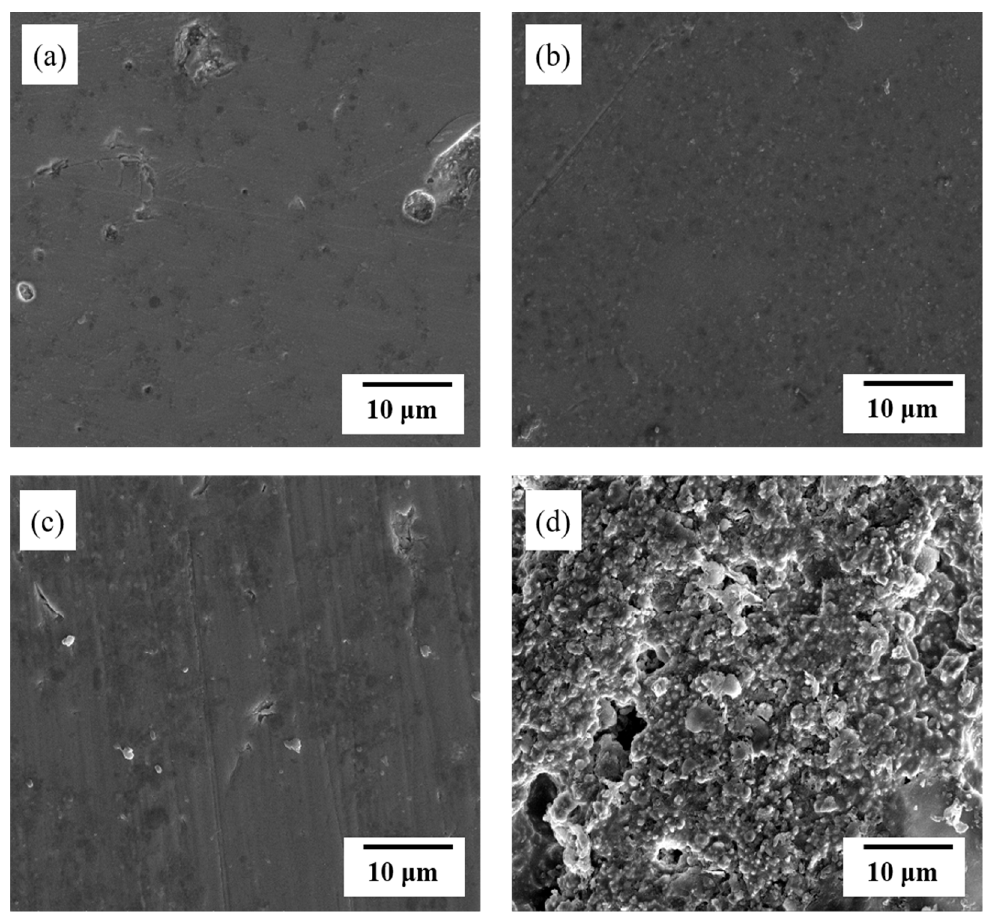
Figure 7. Scanning electron microscope (SEM) images of polished surface of ( a ) 90:10, ( b ) 80:20, ( c ) 70:30, and ( d ) 60:40 wt % glass/Al 2 O 3 composite samples.